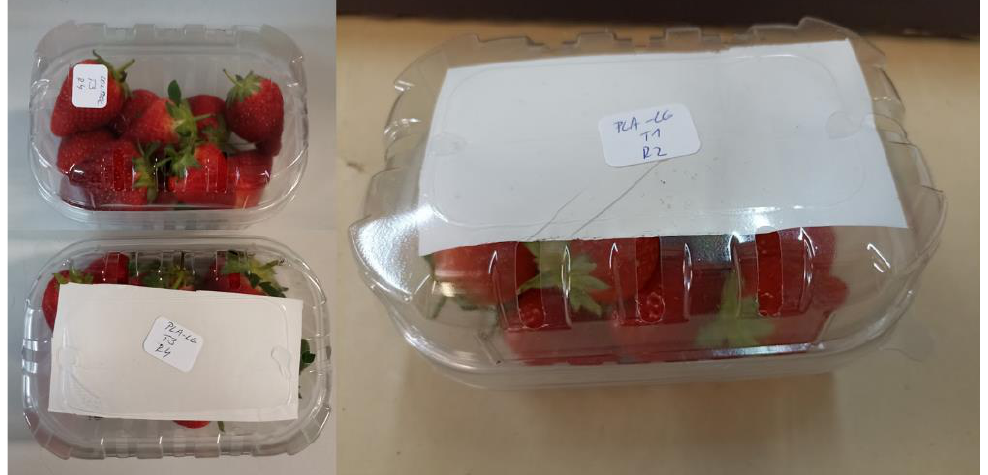
Figure 1. The application of biodegradable nanofibrous membranes (PLA/PHB/ATBC + 5% EO) in active packaging of strawberries.